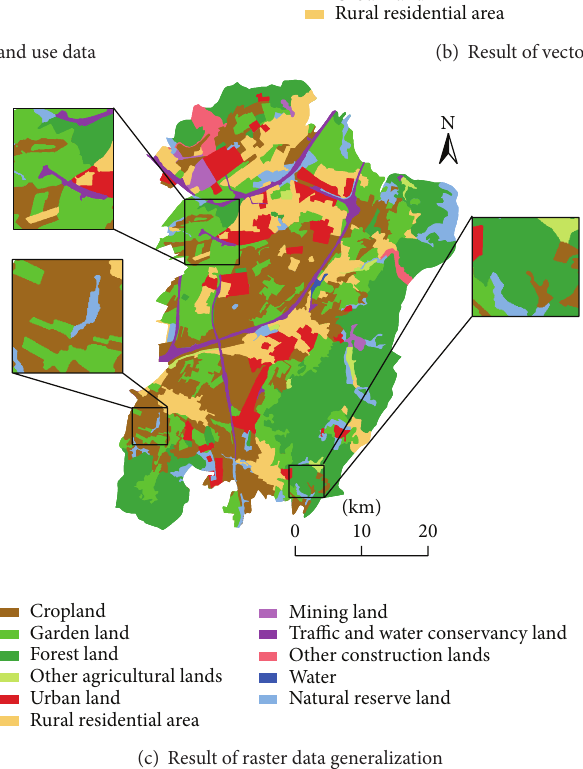
Figure 5: Contrast between result of generalization and original data of land